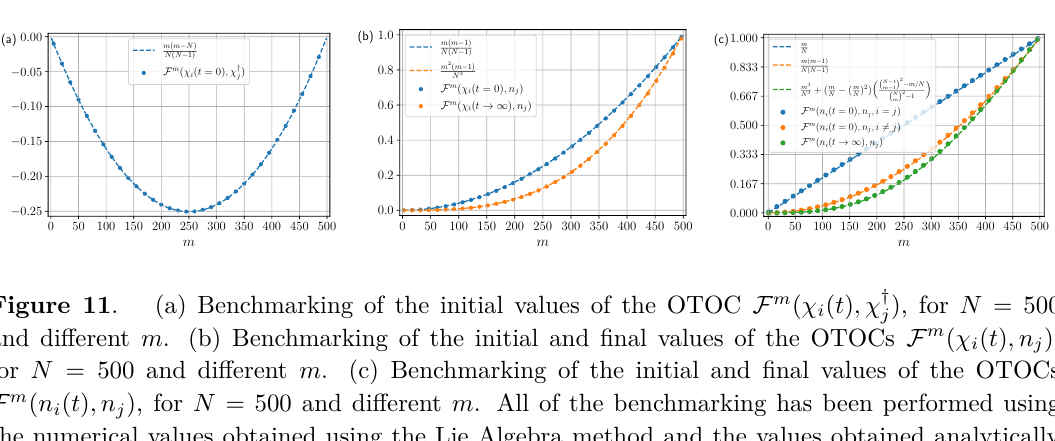
( t ) , χ † ) , for N = 500 i j ( t ) , n ) , i j